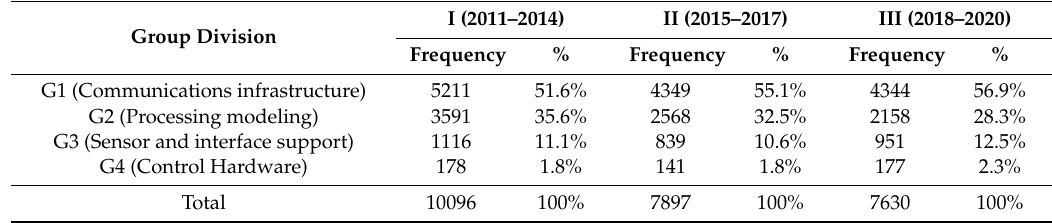
Table 2. Characteristics of DOF development by time